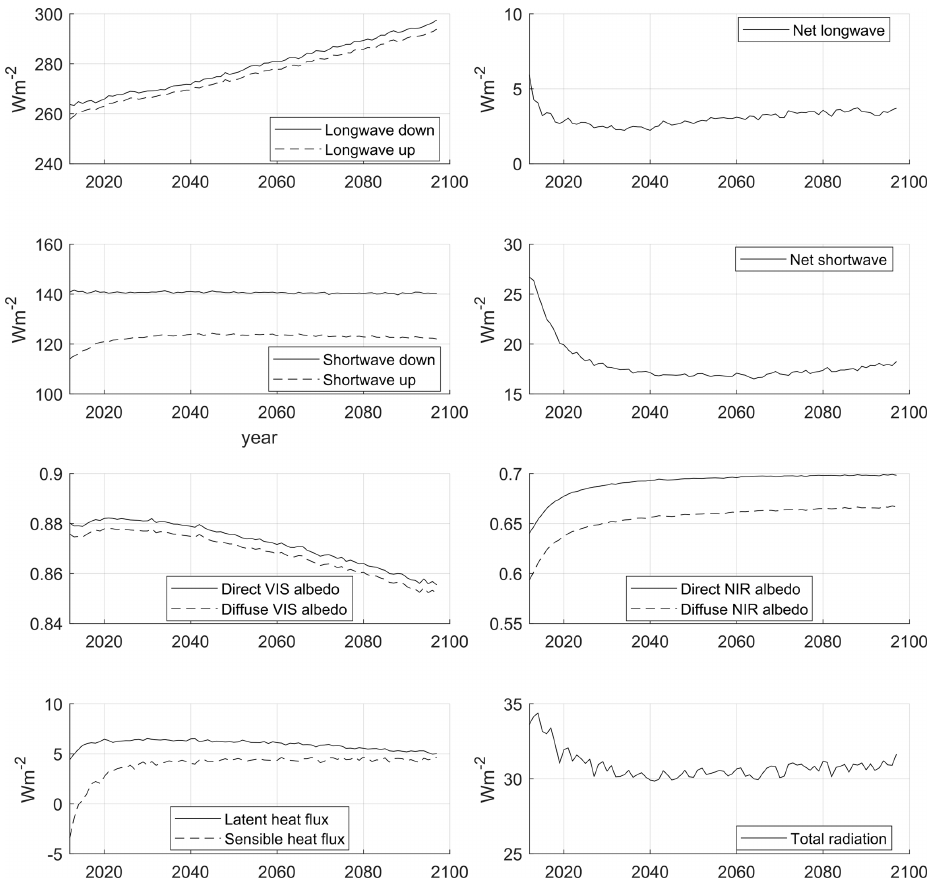
Figure 11. Ensemble mean energy balance components averaged over all glaciated regions and all elevation bands when the model is forced with HadGEM3-A